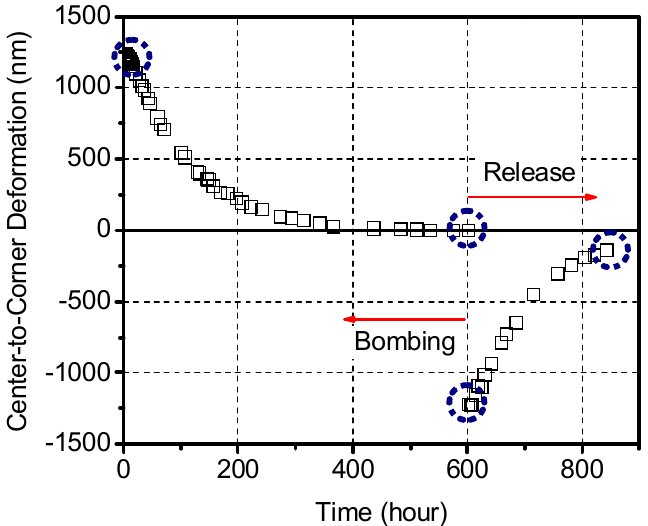
Figure 13. Effective chip surface deflections during the bombing and release stages; the encircled values correspond to the contour maps shown in Figure